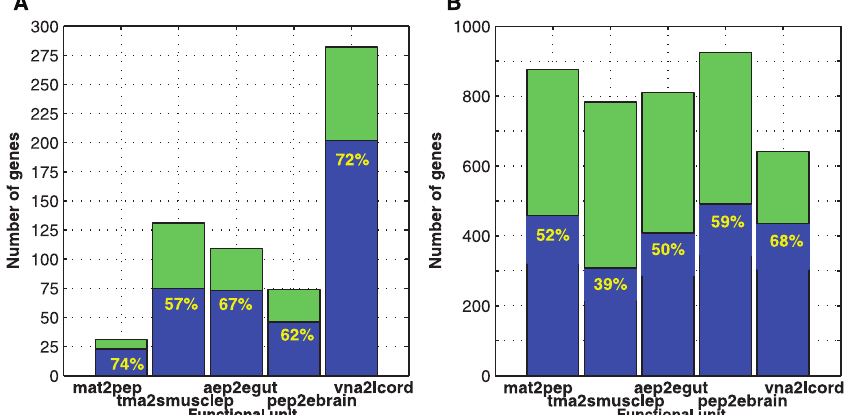
Figure 3. Verification of De Novo Gene Expression Localization Predictions Obtained by Applying Selected SVM Classifiers to Microarray Data (A) Verification using FlyBase literature data. The total height of each bar represents the number of genes associated with each functional unit according to FlyBase. The fraction of these correctly predicted by our classifiers is shown in blue. For the remainder (green fraction), the classifier makes negative predictions. (B) Verifications using the GO:Biological Process hierarchy. Here, the height of the bars corresponds to the total number of positive predictions from the selected classifier. The fraction of these predictions supported by GO annotations is in blue, and the remainder is shown in green. As annotation information does not constitute a complete picture, we cannot reliably estimate true-positive and false-positive rates in the conventional sense from such literature verifications (see Materials and Methods), but these values can be extrapolated from the operating point of the ROC curves.